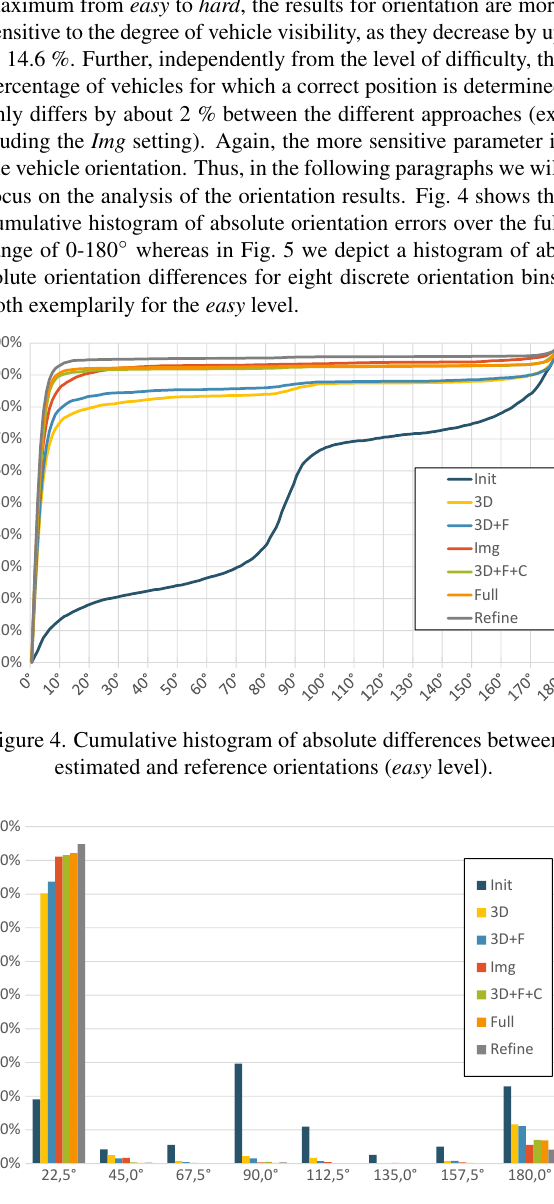
Figure 5. Histogram of absolute differences between estimated and reference orientations ( easy